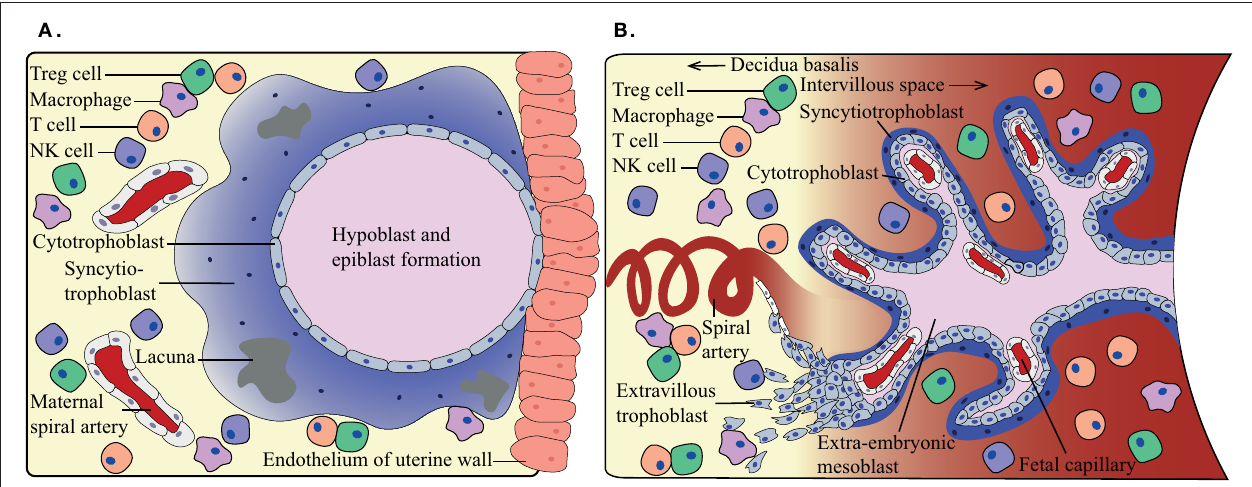
FIGURE 1 | Schematic overview of the maternal-fetal interface at different trimesters. (A) During first-trimester, the maternal immune cells in the decidua can come into contact with fetal syncytiotrophoblasts, when around weeks 11–12 the maternal blood flow commences (B) a second maternal-fetal interface occurs. The maternal immune cells in the periphery can come into contact with fetal syncytiotrophoblasts, while the maternal decidual immune cells are in contact with the fetal extravillous trophoblasts. Indicating immunotolerance needs to adapt during the shift in